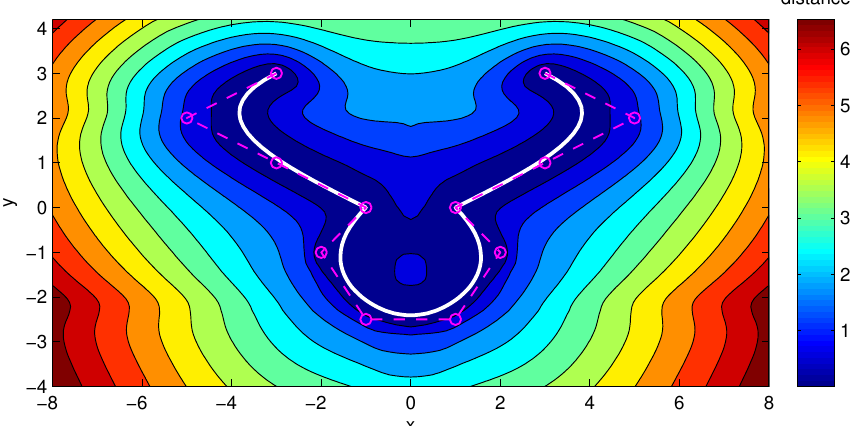
Figure 6. Algebraic level sets of a symmetric cubic spline. G 0 continuity is present at ( x , y ) = ( − 1,0 ) and ( 1,0 ) . The generated algebraic level sets retain the symmetry while ensuring the smoothness of the